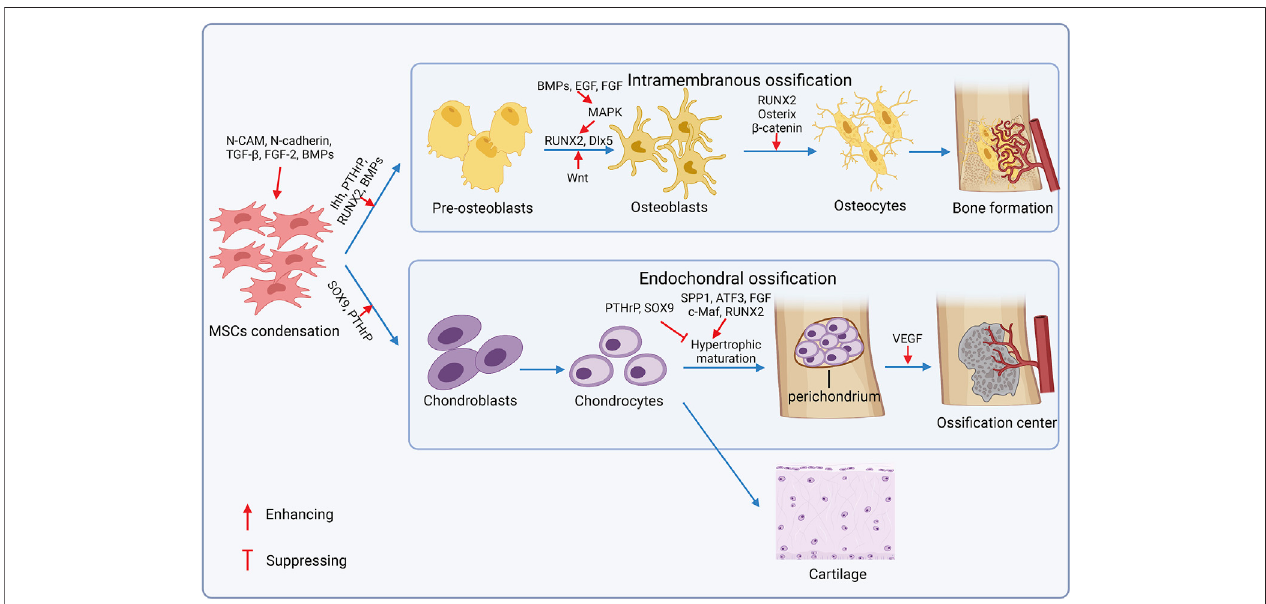
FIGURE 3 | Mechanisms of osteogenesis and chondrogenesis. In bone remodeling sites, MSCs aggregate and form mesenchymal condensations. Then, bone is formed in two ways: intramembranous ossi fi cation and endochondral ossi fi cation. During the intramembranous ossi fi cation process, MSCs are differentiated into pre- osteoblasts, then they lost proliferation capacity and mature into osteoblasts, which secret alkaline phosphatase and osteocalcin that participate in the secretion, maturation, and mineralization of the extracellular matrix (ECM). In endochondral ossi fi cation, differentiated chondrocytes either proliferate in cartilage elements or exhibit hypertrophic maturation for subsequent endochondral ossi fi